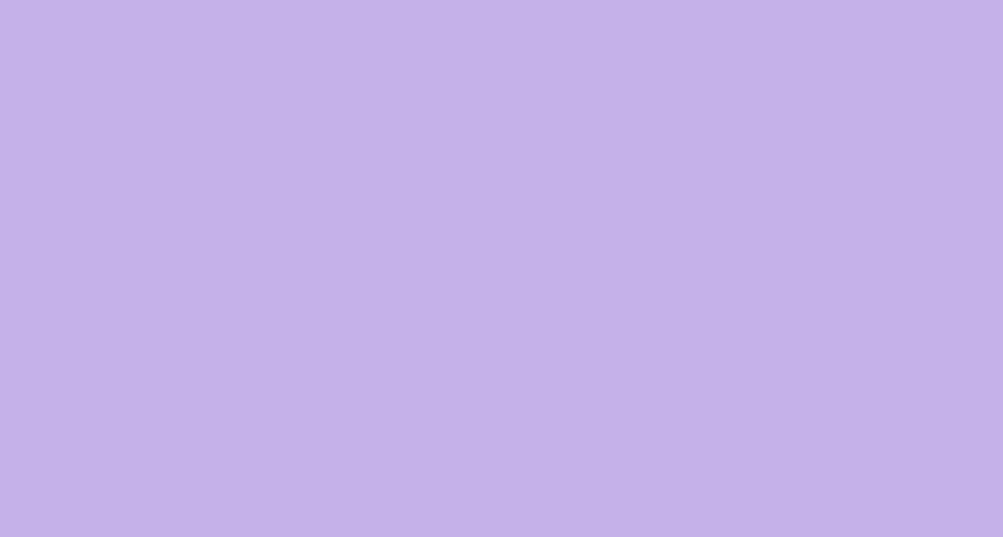
Figure 4: Main simulation platform.